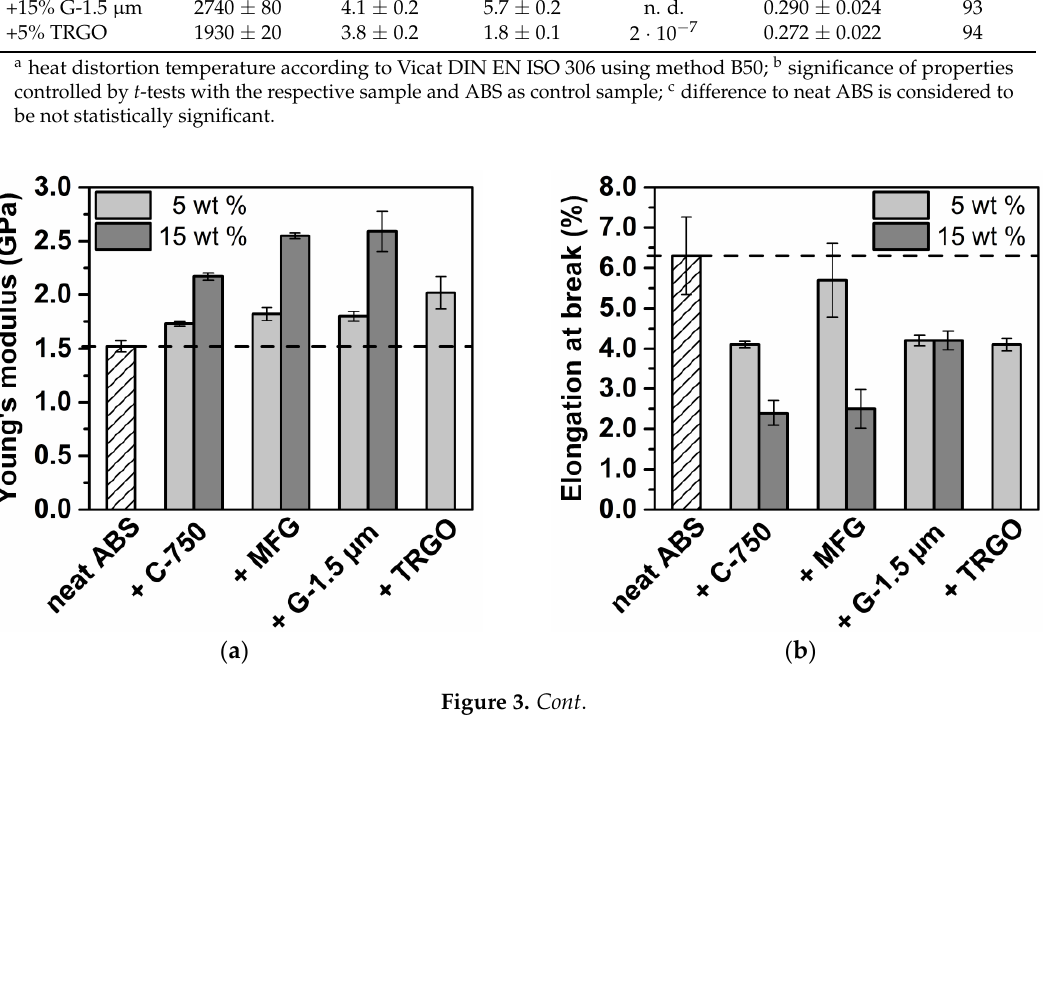
Table 3. Properties of carbon/ABS